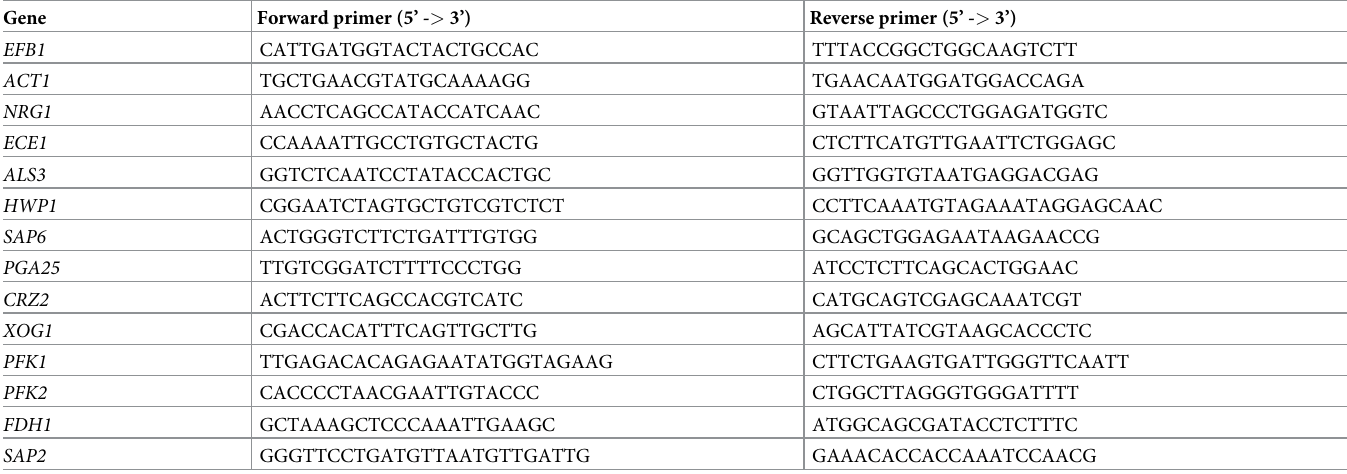
Table 4. Primers for detecting C. albicans transcripts 1